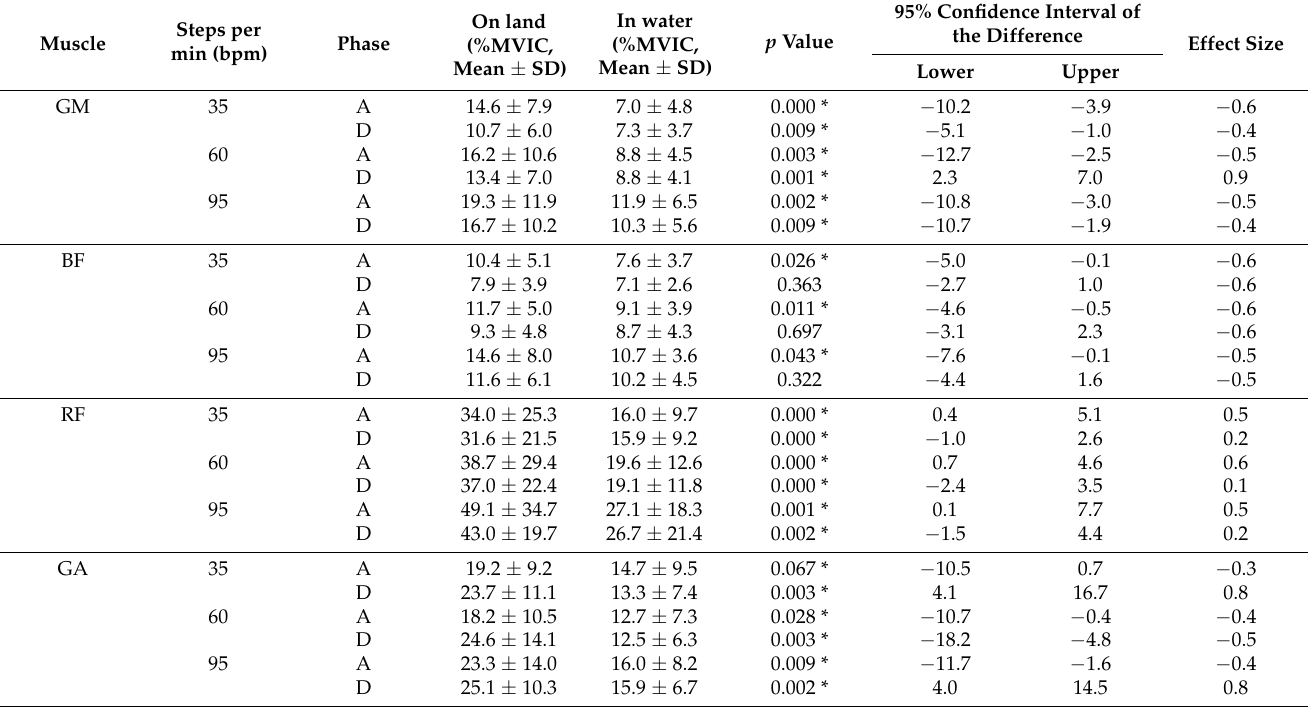
Table 2. The comparison of tested muscle activation at different media (GM = gluteus max- imus, RF = rectus femoris, BF = biceps femoris, GA = gastrocnemius, A = ascending phase, D = descending